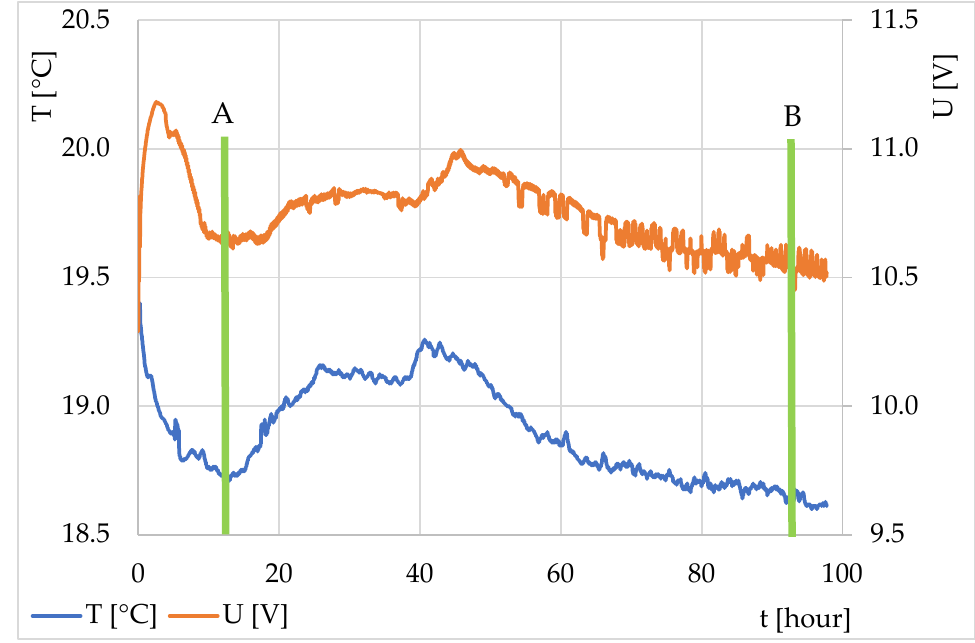
Figure 6. Monitoring of top fermentation of wort in Experiment No. 2—dried yeast directly from the refrigerator. Curve description: orange, TDS output voltage; blue, temperature of the plastic fermentation vessel. Lines a and b indicate the beginning and end of the fermentation process.